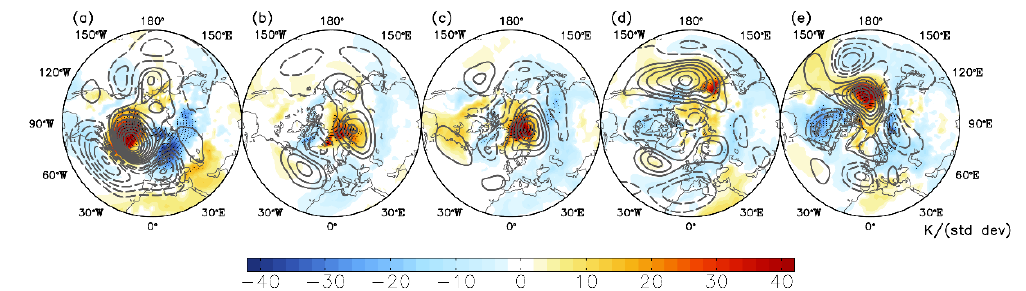
Figure 2. Regression patterns of the detrended winter 500-hPa geopotential height (contours, unit: gpm) and surface atmosphere temperature (SAT, shading, unit: K) anomaly against the detrended DJF mean SIC anomaly (multiplied by − 1) over region ( a ) Baffin Bay, ( b ) Greenland Sea, ( c ) Barents-Kara Seas, ( d ) Okhotsk Sea and ( e ) Bering Sea during 1979–2016. The dotted areas represent values that are above the 95% confidence level based on a two-sided Student’s t test.